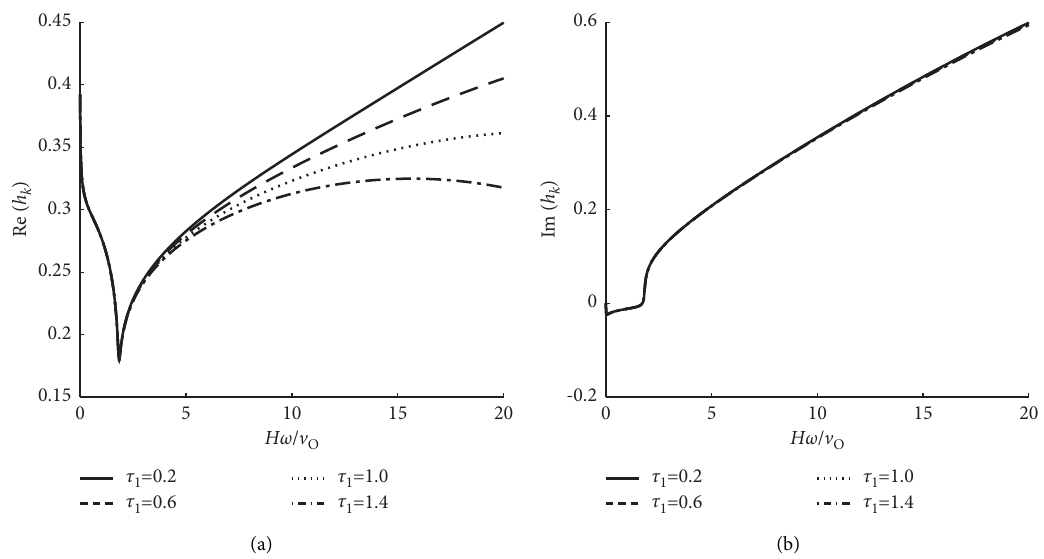
Figure 7: The impedance factor curves of soil layers under different model parameter ratios ( τ the soil layer. (b) Horizontal damping factor of the soil layer.